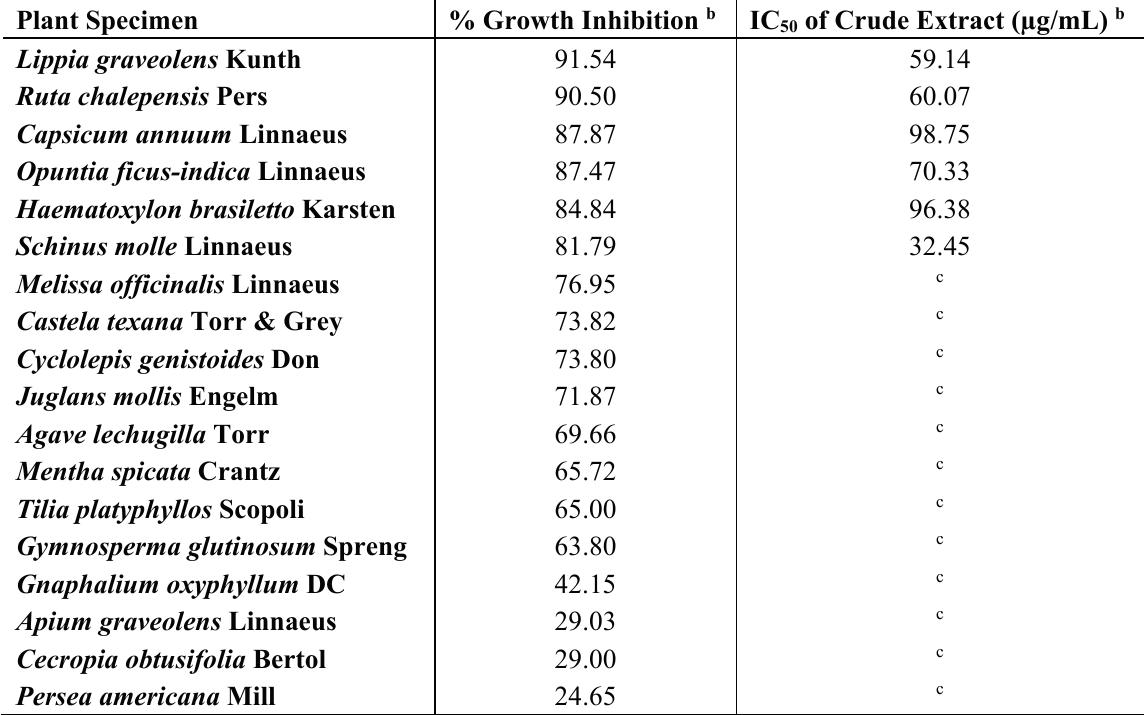
Table 2. Antiprotozoal activity against Entamoeba histolytica of methanolic extracts a from selected